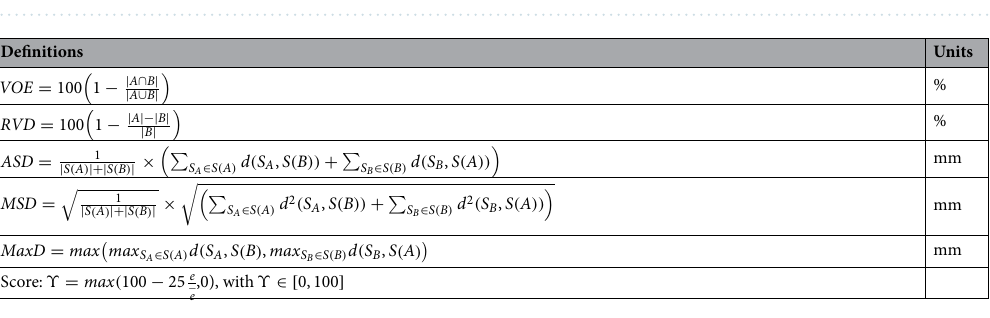
Figure 6. The performance of BN-CC shown on two consecutive slices (top and bottom rows). The previous and current contours are draw in green and orange colors, respectively. The ground truth is drawn in white. The first column ( a and d ) shows the bottle neck detecting in CT image after applying graph-cut. The second column ( b and e ) shows the results after applying adjacent contour constraint. The last column ( c and f ) shows the valid contours. Red and blue circles indicate the removed and remaining bottlenecks, respectively.